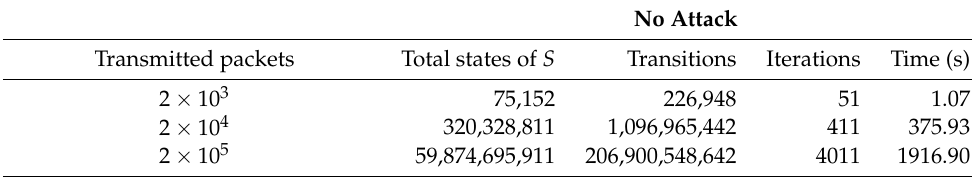
Table 3. State space